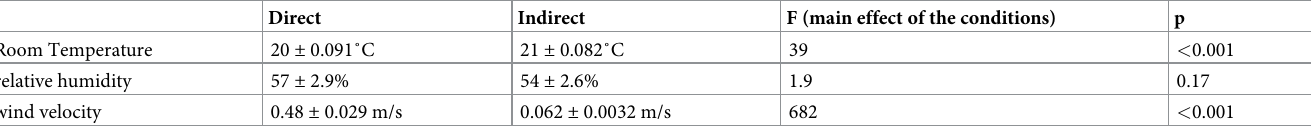
Table 3. Main effect of the two airflow conditions and p value from the ANOVA for physical parameters. Direct Indirect F (main effect of the conditions)